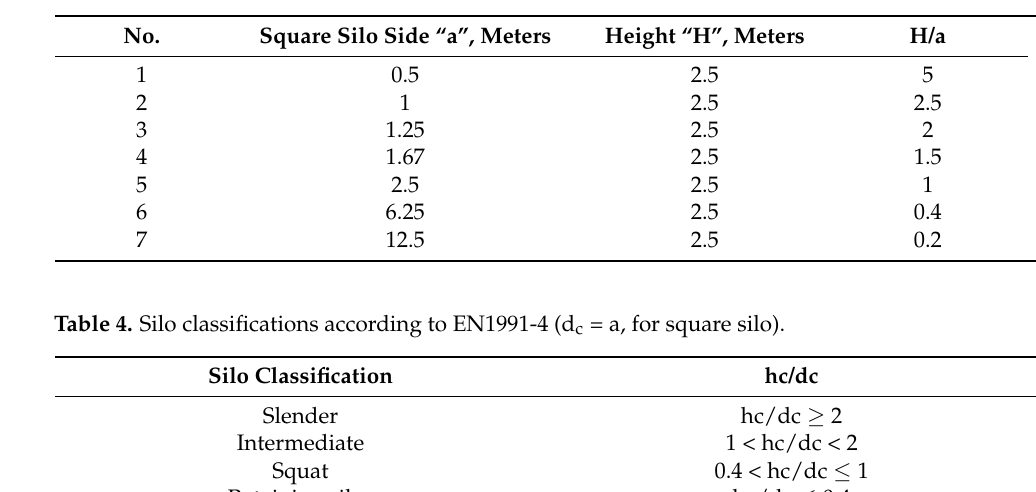
Table 3. Silos with different planform dimensions.